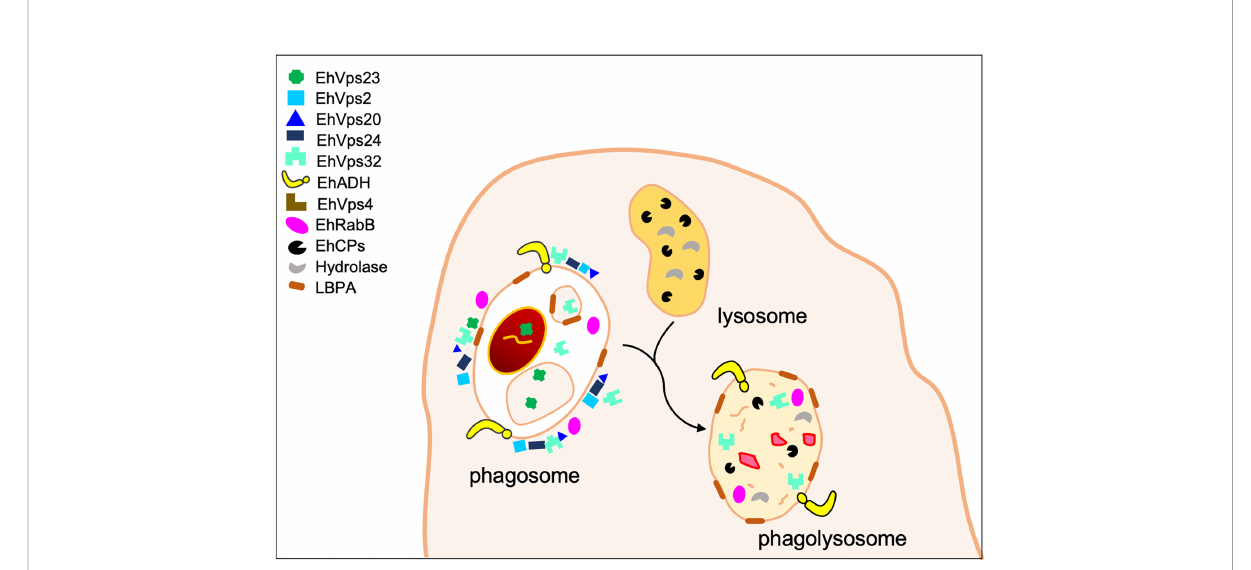
FIGURE 4 Lysosomal degradation. Particularly during phagocytosis, LE/MVBs are also called late phagosomes. They fused to lysosomes for generating phagolysosomes. Lysosomes are enriched in hydrolases, which contribute to degrade molecules in the phagolysosomes. In the latter, ESCRT-III and ESCRT accessory proteins, together with EhRabB and LBPA, are also